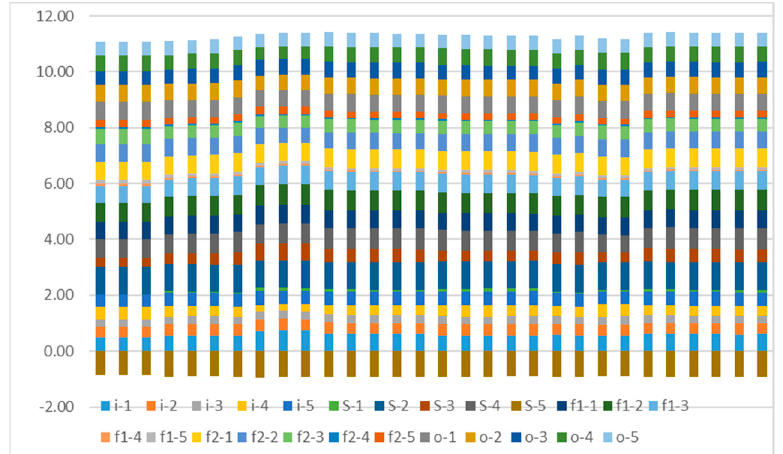
Figure 13. The values of intermediate variables coming from 30 continuous windows in a batch behind the grid cell (50, 40). Each color of the figure shows the corresponding value of the type of intermediate variable. For example, the “ i − 1” variable shows the first element of the i t,s.